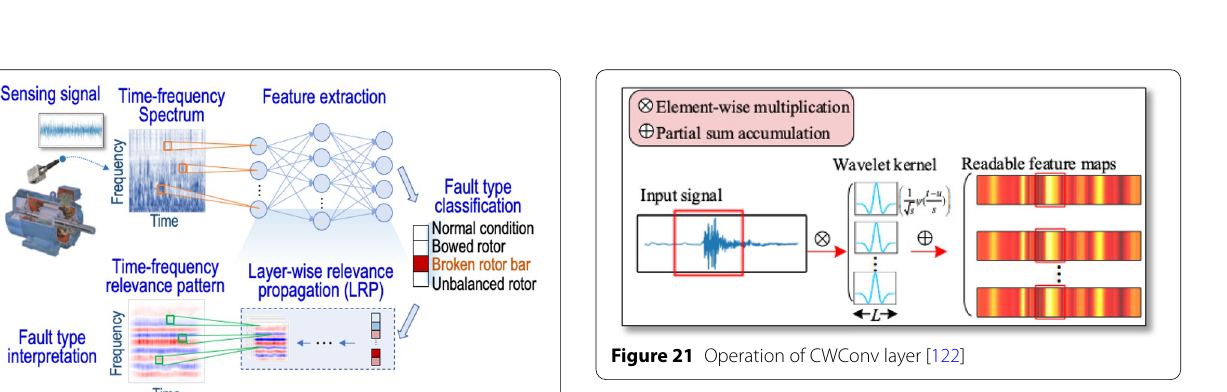
Figure 19 Flowchart for fault-related information extraction from text documents based on NLP [89] (The input (in Chinese) means “the drain valve does not match the pressure applied”)